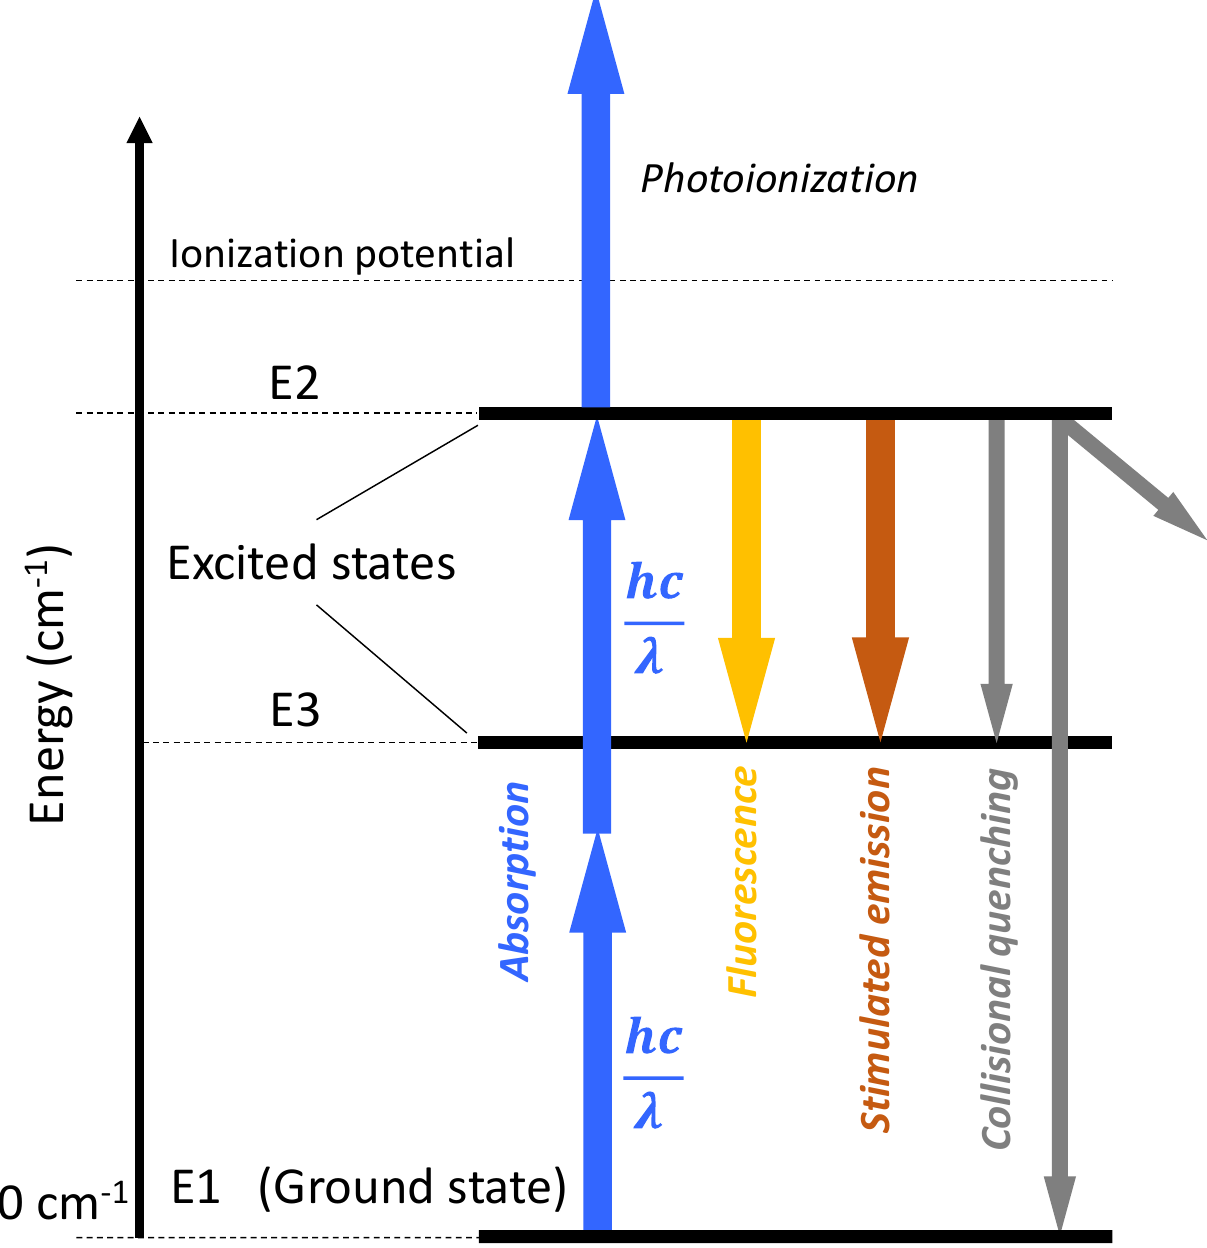
Figure 2. Generalized two − photon absorption (i.e., 2 × hc / λ , with h , c , and λ being the Planck’s constant, light speed, and laser excitation wavelength, respectively) and TALIF detection scheme for an atomic species.